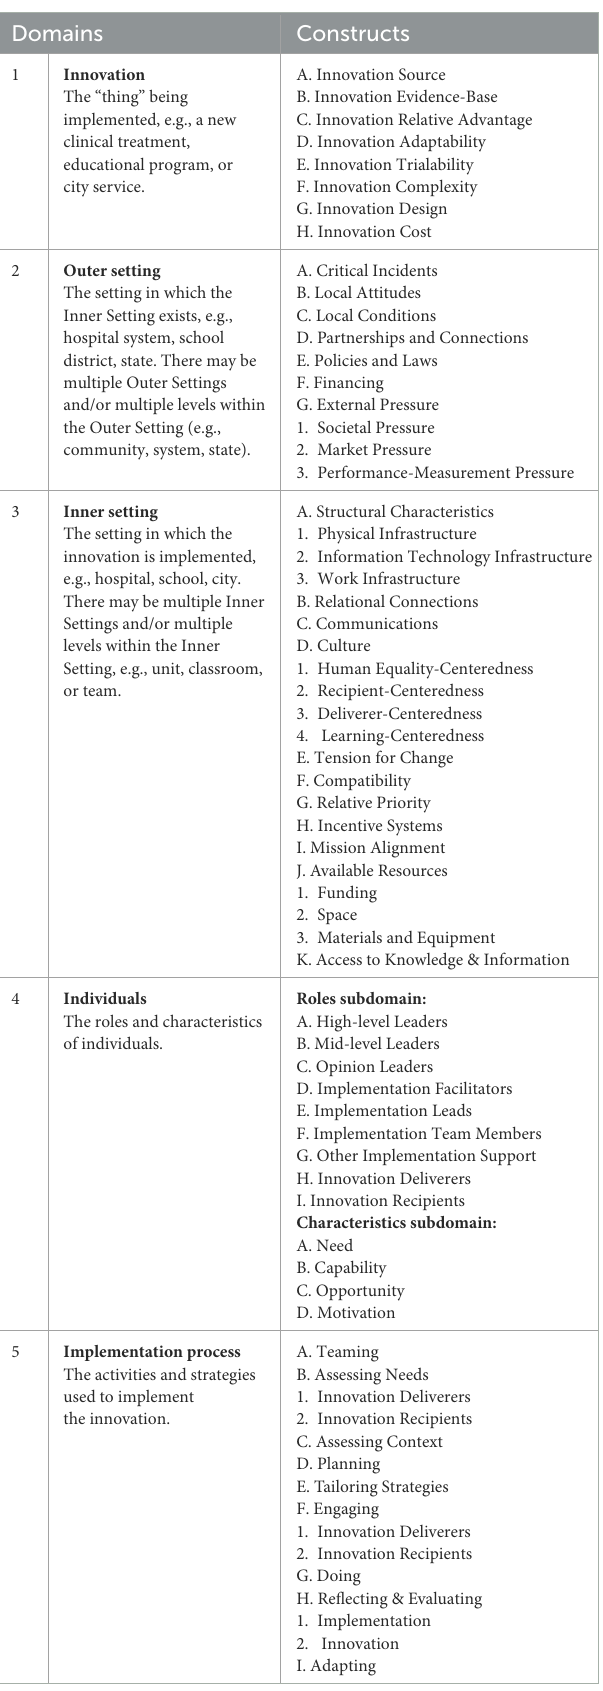
TABLE 2 CFIR domains and constructs